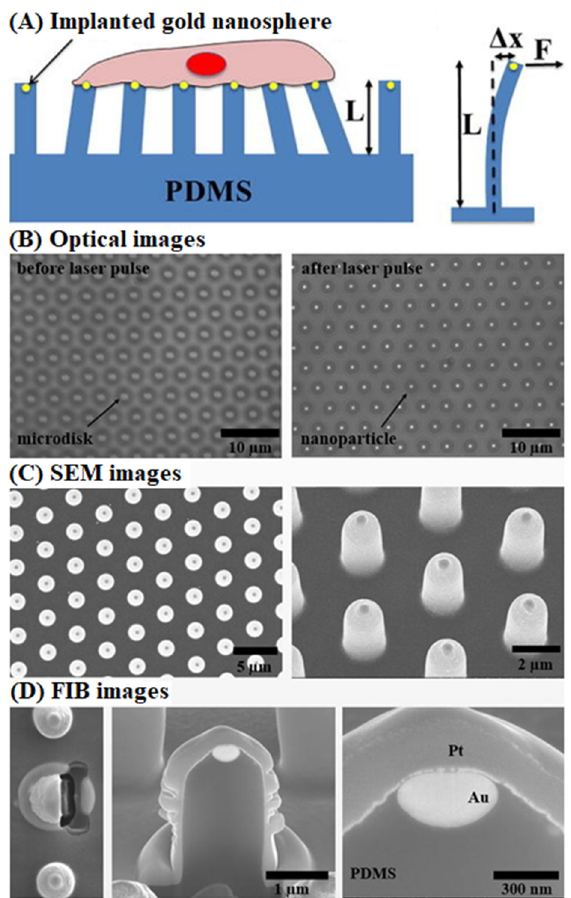
Figure 5. ( A ) Schematics of a plasmonic micropillar platform for the cell force measurement. Each polymer micropillar tip is embedded with a single gold nanosphere that serves as a strong and point-source-like light source for precision position tracking. ( B ) Microscopy optical images which show that gold microdisks transformed into gold nanospheres after pulse laser annealing. ( C ) Scanning electron microscopy (SEM) images show micropillars with transferred gold nanospheres. ( D ) Focused ion beam (FIB) images show that these transferred gold nanospheres are physically anchored inside the pillar and have an oblate spheroid shape with a long axis of 473 nm and a short axis of 268 nm. Platinum (Pt) coating shown in the images is for FIB imaging and not a part of the original pillar structure. Modified from [113].